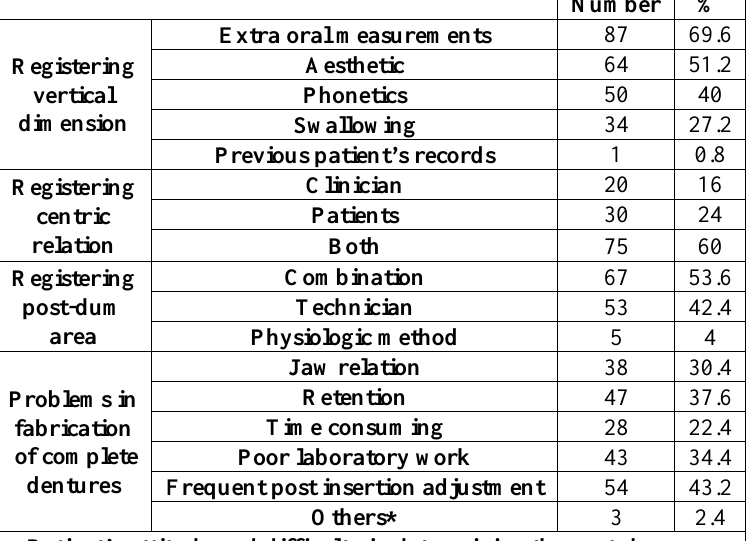
Table 7: Methods of registration vertical dimension, centric relation records and post-dum area in addition to the main problems in fabrication of complete